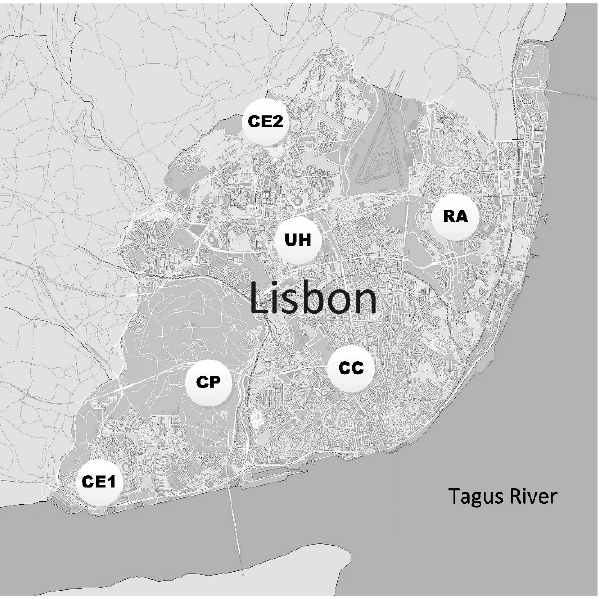
Figure 1. Soil sampling sites in the city of Lisbon.